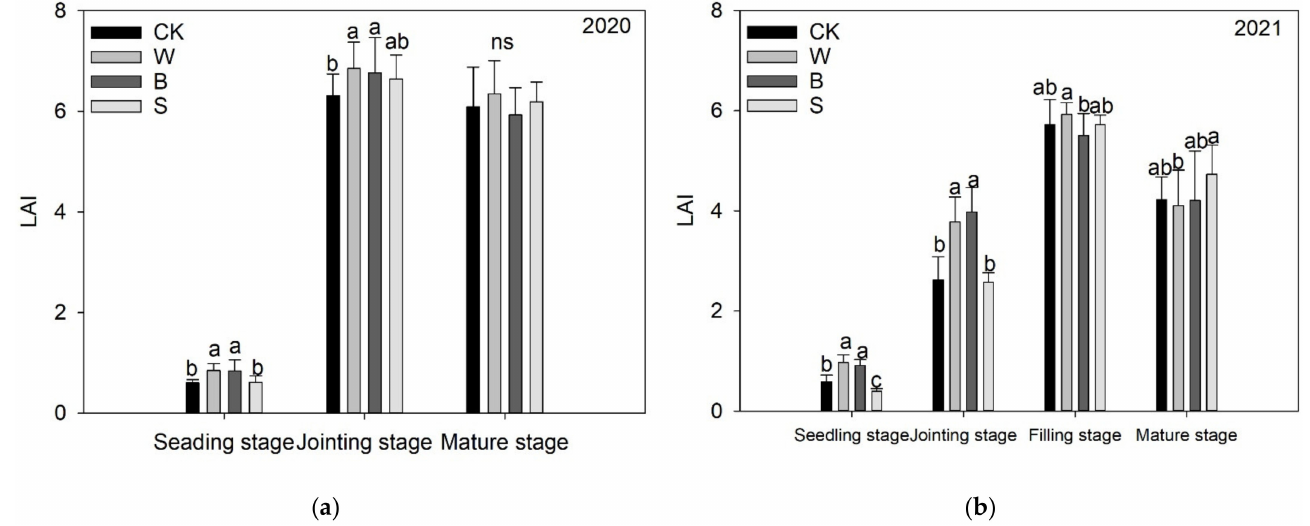
Figure 3. LAI changes under different coverage treatments in 2020 ( a ) and 2021 ( b ). Different lower- case letters (a, b, and c) in the table indicate statistically significant differences, ns represents no significant differences at 0.05 < p < 0.1.